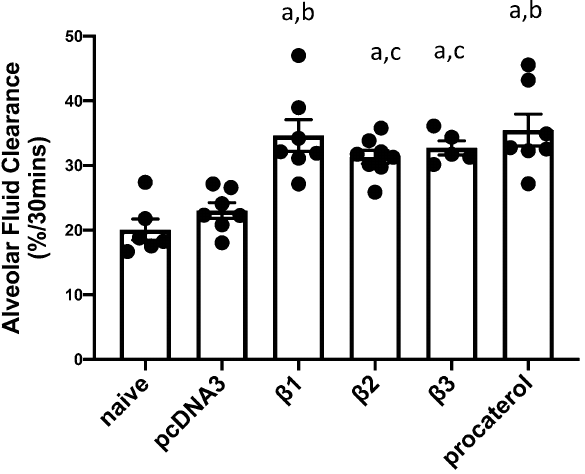
Figure 1. Electroporation mediated gene transfer of β1, β2, and β3 subunits of the Na + ,K + -ATPase upregulate alveolar fluid clearance in mice. Plasmids (100 μg each) expressing either no insert (pcDNA3), or the β1, β2, or β3 subunits of the Na + ,K + -ATPase (β1, β2, or β3) were delivered in 50 μl to the lungs of C75B6 mice (n = 6–7) by aspiration followed immediately by electroporation (8 pulses of 10 ms duration each and 200 V/cm). Naïve mice received no DNA. Two days later, alveolar fluid clearance was measured in living mice and calculated based on the change in concentration of Evans Blue Dye-labeled albumin in an isosmolar (324 mOsm) instillate placed into the alveolar space and mechanically ventilated over a 30 min period. Procaterol (10 –8 mol/L) was administered in the instillate and used as the positive control in a set of naïve mice. Rates of alveolar fluid clearance are shown as mean ± SEM. All experiments were carried out three times and a